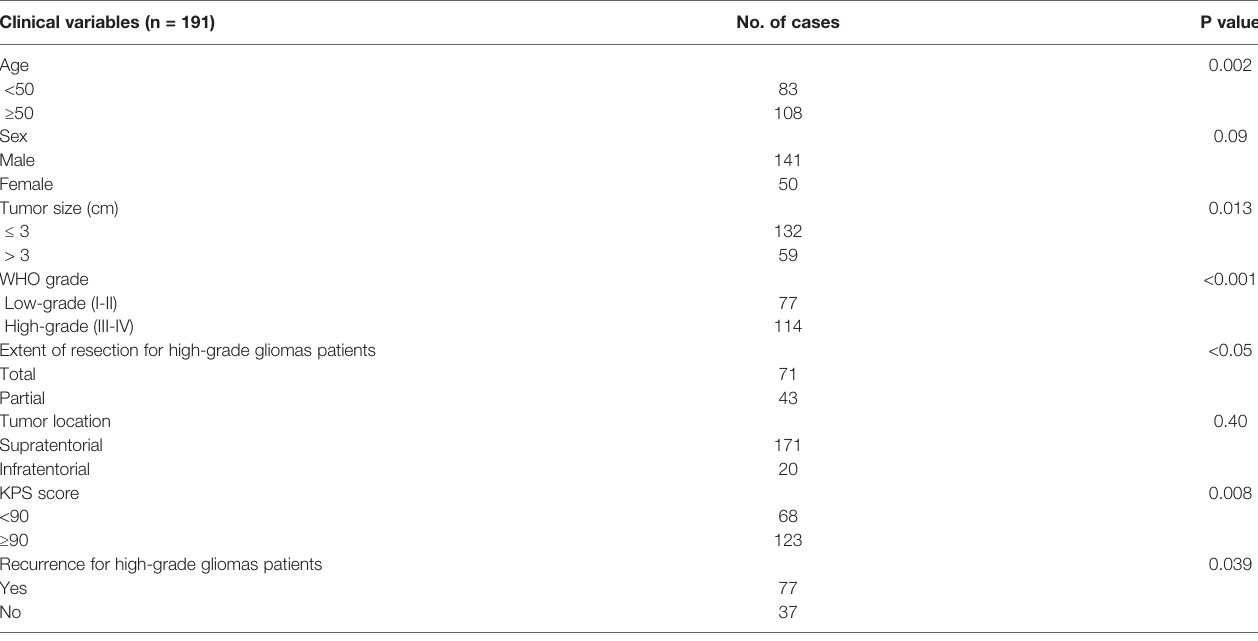
TABLE 1 | Clinicopathological characteristics of glioma patients for the study of circulating miRNAs. Clinical variables (n =